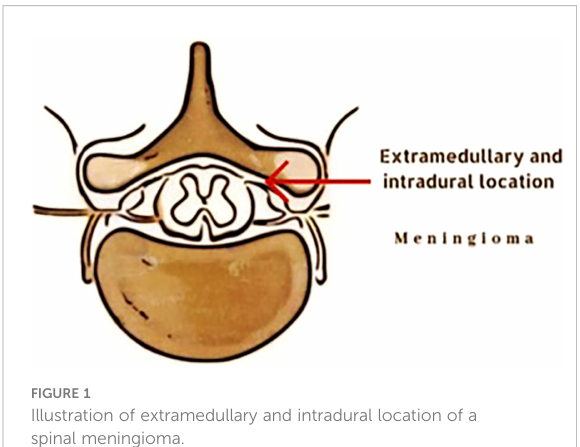
FIGURE 1 Illustration of extramedullary and intradural location of a spinal